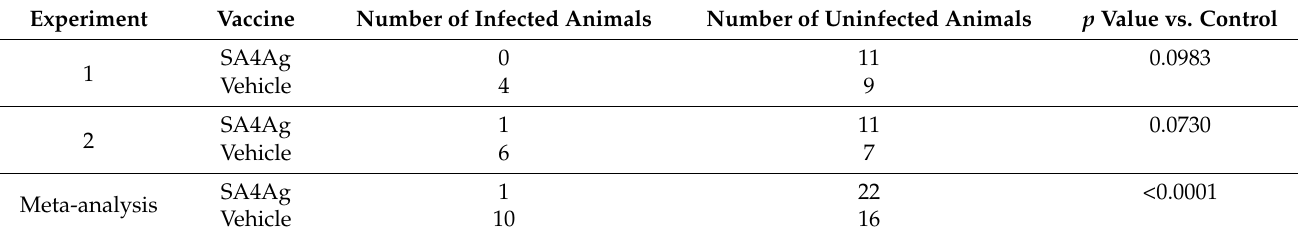
Table 5. Immunization with SA4Ag Reduces the Number of S. aureus Infections in a Rat Endocarditis Model of Infection.